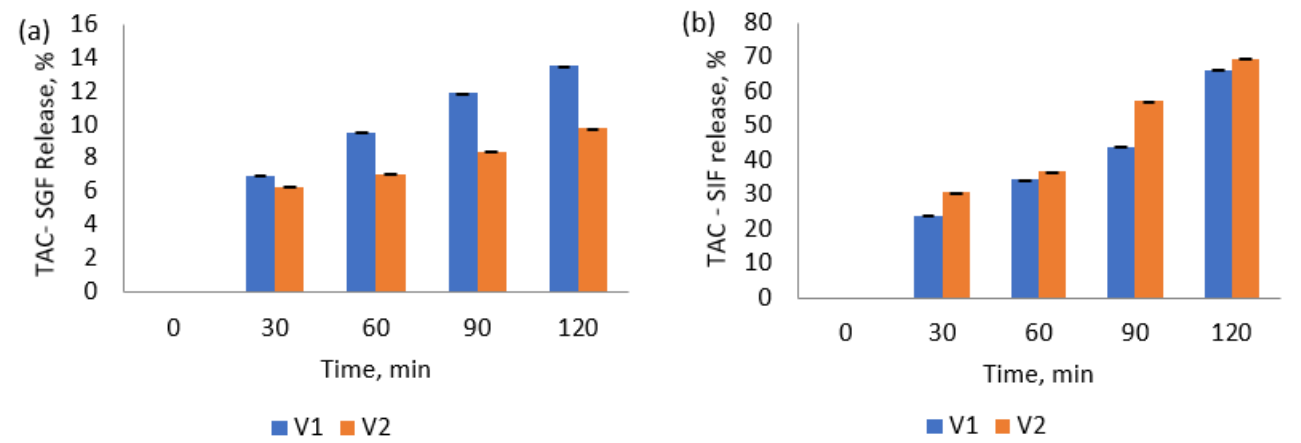
Figure 5. Anthocyanin release from the microcapsule powders during the simulated in vitro gastric ( a ) and intestinal ( b ) digestion.